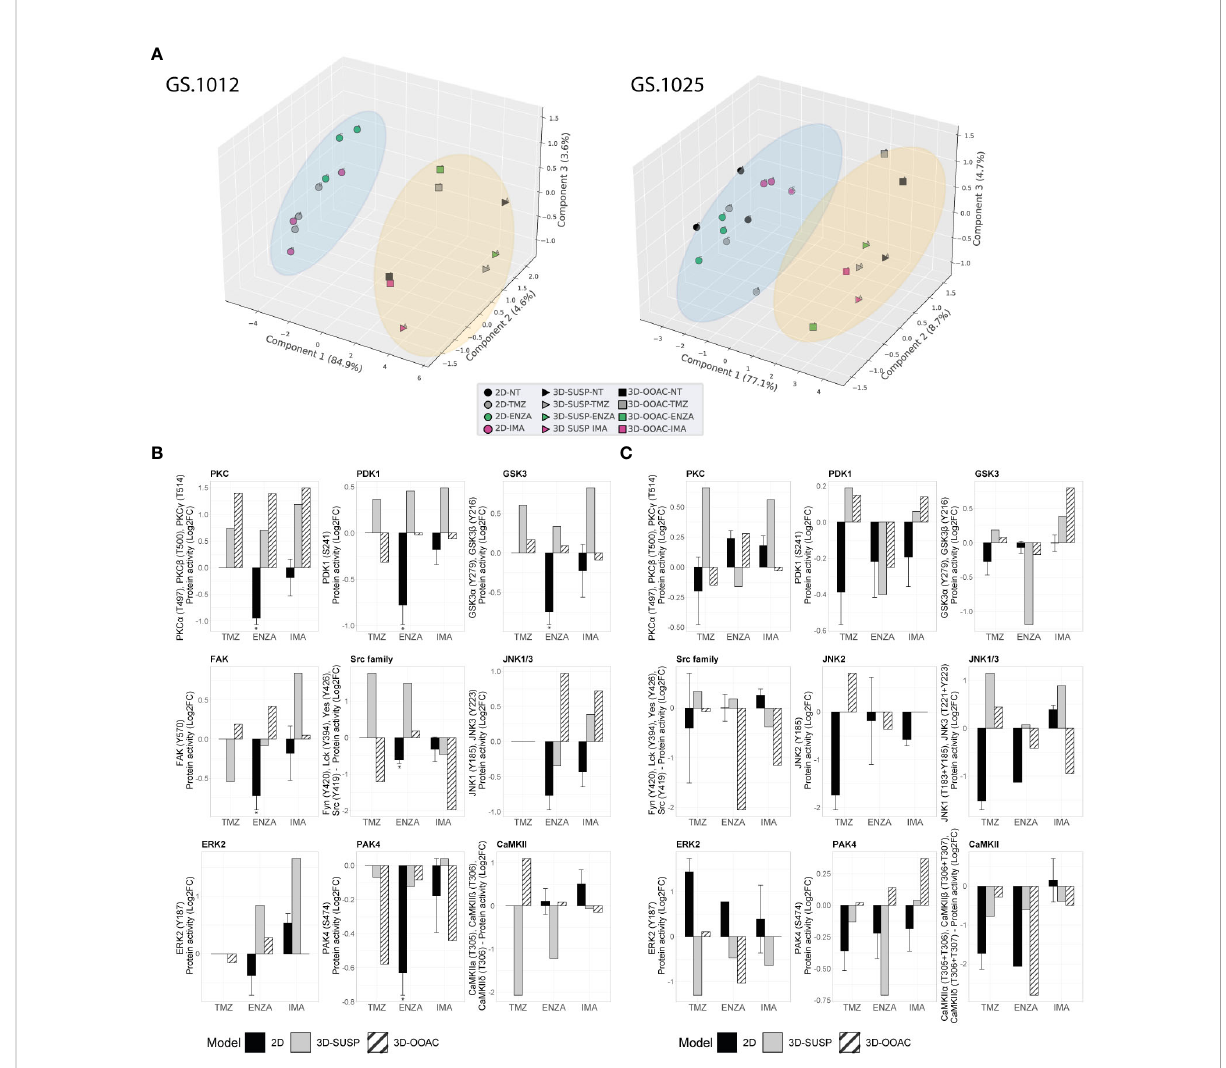
FIGURE 4 Comparison of kinase activity of GS.1012 and GS.1025 2D and 3D OMS cell cultures. (A) Principal component analysis (PCA) of kinase activities. 3D principal component analysis performed on the commonly identi fi ed kinase activities in 2D, 3D-SUSP, and 3D-OOAC of untreated (NT), temozolomide (TMZ), enzastaurin (ENZA), and imatinib (IMA) conditions of GS.1012 (left) and GS.1025 (right). The blue circle clusters the 2D samples, while the yellow circle clusters the 3D OMS samples. (B) Kinase activity of Erbb signaling kinases in 2D and 3D OMS of GS.1012. The barplots show the log2 fold changes values of detected kinases belonging to the Erbb signaling pathways that were identi fi ed in 2D, 3D-SUSP, and 3D-OOAC of temozolomide (TMZ), enzastaurin (ENZA), and imatinib (IMA) conditions normalized to the untreated (NT) control. n(2D)=3 (the absence of error bars indicates that the kinase activity was detected only in one replicate); the kinase activity in 3D samples derives from the pooling of n=22 OMS. * FDR adjusted-p < 0.05. No signi fi cance was calculated when the kinase activity was detected in less than 3 replicates. (C) Kinase activity of Erbb signaling kinases in 2D and 3D OMS of GS.1025. The barplots show the log2 fold changes values of detected kinases belonging to the Erbb signaling pathways that were identi fi ed in 2D, 3D-SUSP, and 3D-OOAC of temozolomide (TMZ), enzastaurin (ENZA), and imatinib (IMA) conditions normalized to the untreated (NT) control. n(2D)=3 (the absence of error bars indicates that the kinase activity was detected only in one replicate); the kinase activity in 3D samples derives from the pooling of n=15 OMS. * FDR adjusted-p < 0.05. No signi fi cance was calculated when the kinase activity was detected in less than 3